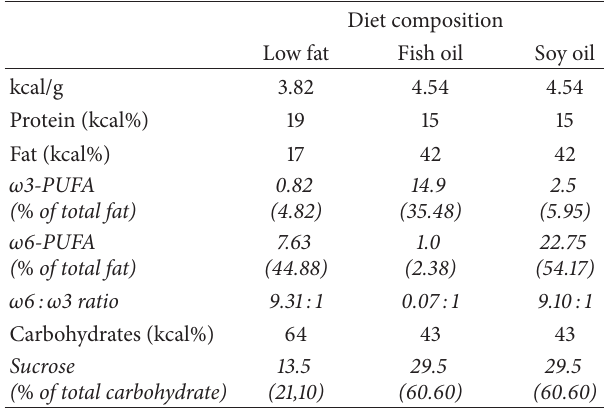
Table 1: Diet composition of the three different diets. A detailed description can be found in supplementary Table